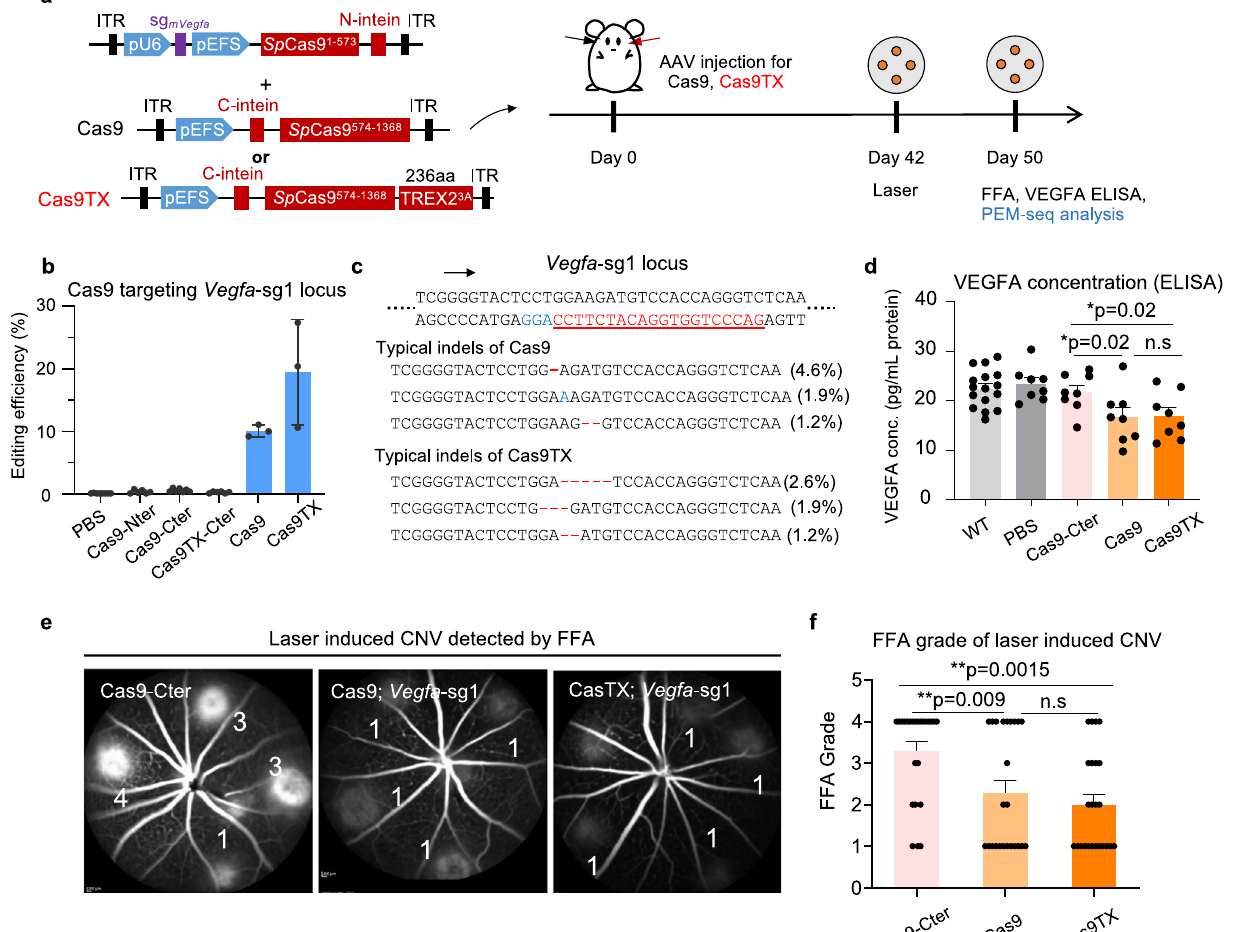
Fig. 2 | Cas9TX is able to ef fi ciently inhibit CNV. a Schematics for treatment for AMD in mouse models by Cas9TX and Cas9. Cas9TX and Cas9 are packaged into dual-AAV systems. At 42-days post infection of the resulting AAVs into the mouse eyes, neovascularization is induced into the mouse eyes by laser. One week later, the neovascularization in the mouse eyes is monitored by FFA, the protein level of VEGFAisdetectedbyELISA,andchromosomalstructuralvariationsaredetectedby PEM-seq analysis. b Editing ef fi ciency at Vegfa -sg1 for the indicated groups in mousemodelsofAMDdetectedbyPEM-seq.Errorbars,mean±SD(ForPBS-,Cas9- Nter-, Cas9-Cter-, Cas9TX-Cter-, Cas9-, and Cas9TX-treated mouse models, n =5,5, 4,5,3,and3,respectively). c ExamplesofDNAsequencesfortypicalindelsinduced